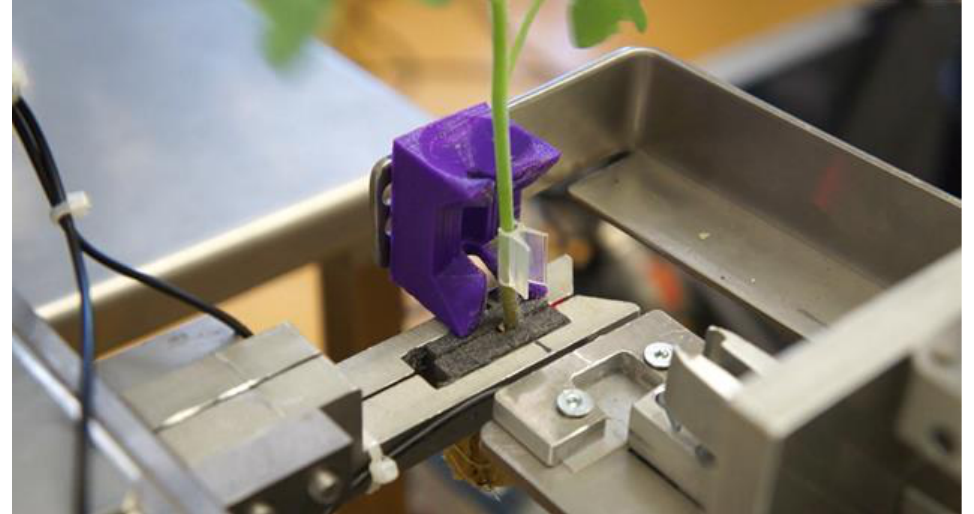
Figure 6. Detailed view of the fitting device and the grafting clip placement. It can be seen that the grafted plant is clamped by the robot that holds the rootstock and that the grafting clip is in place. Demonstrative video of the system: https://youtu.be/CgJE3NxJ0sA (accessed on 1 April 2020).